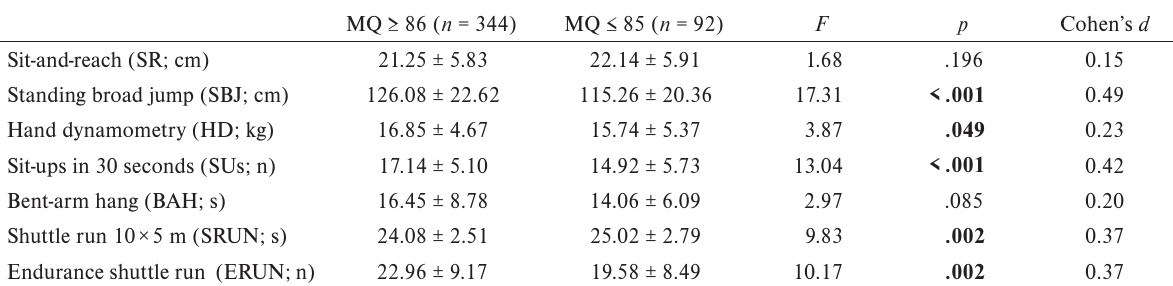
Comparison of physical fitness indicators (presented as M ± SD) in the group of girls and boys aged 7 to 10 years (N = 436) from the point of view of MQ KTK MQ ≥ 86 ( n =